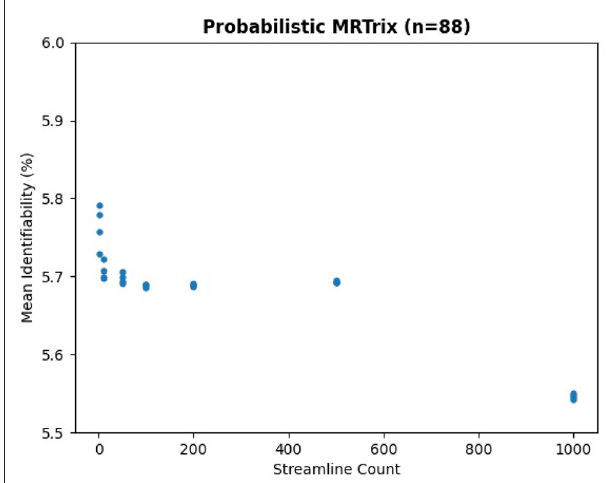
FIGURE 8 | Mean identifiability with all patients using probabilistic MRTrix ( q = 4 random seeds per streamline count, k = 20 subset size, r = 10 repetitions, iFOD2